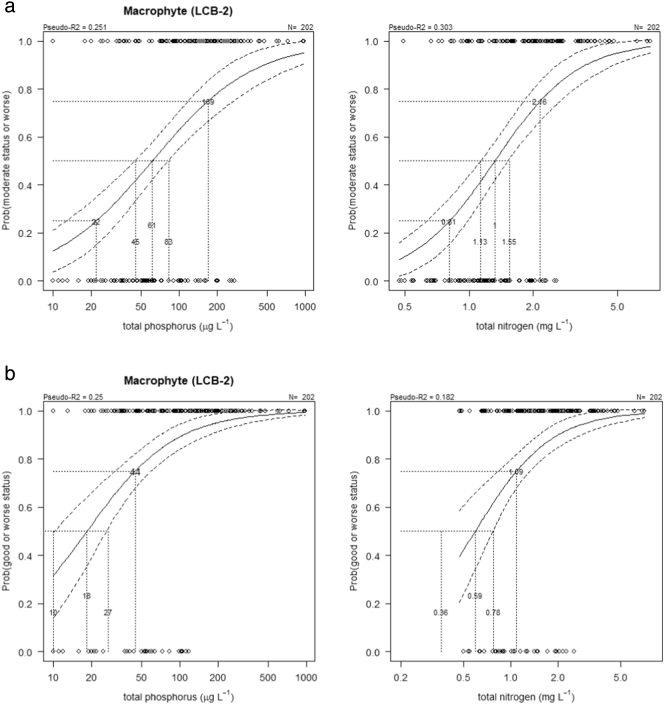
Binary logistic regression (± 95% confidence limits) between total phosphorus/nitrogen and the probability of macrophytes from high alkalinity very shallow (L-CB2) lakes being classified as a) moderate or worse, b) good or worse. Lines show potential good/moderate and high/good boundary values at p = 0.5 and intersections with fit ±95% confidence limits, and alternative values at p = 0.75 and p = 0.25 (good/moderate only) reflecting differing levels of precaution.